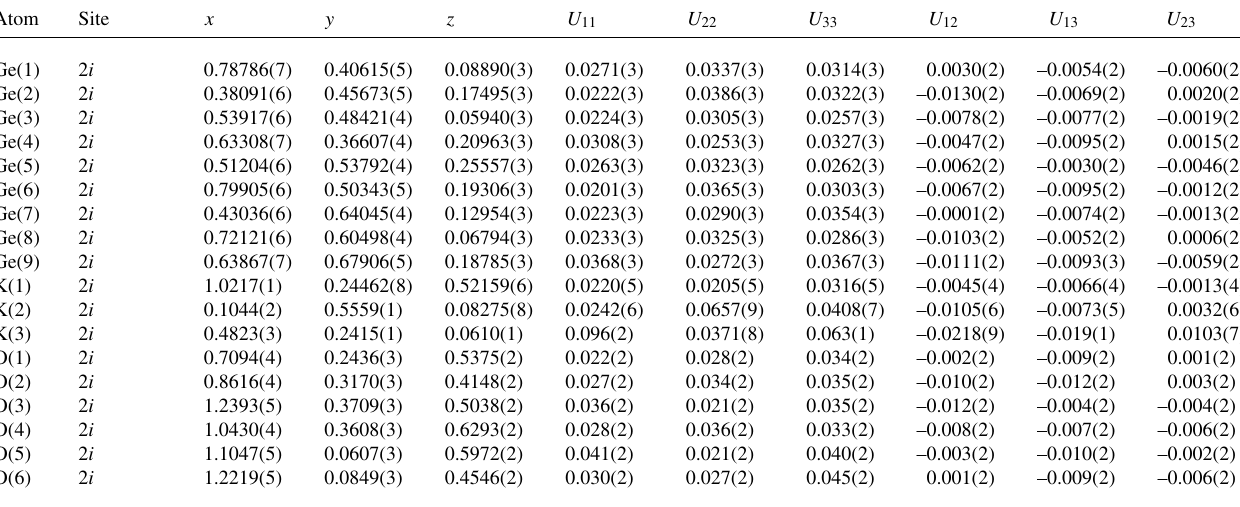
Table 3. Atomic coordinates and displacement parameters (in Å 2 ) .